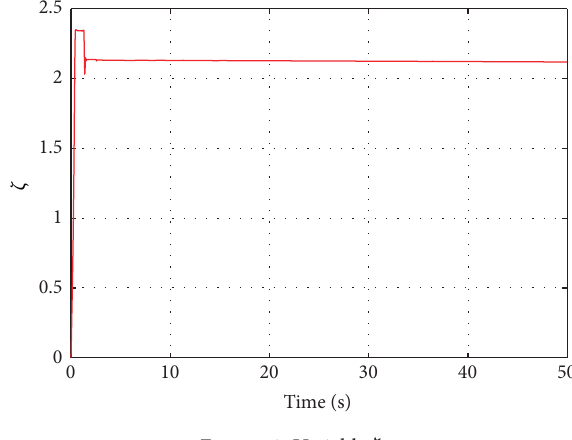
Figure 9: Variable 𝜁